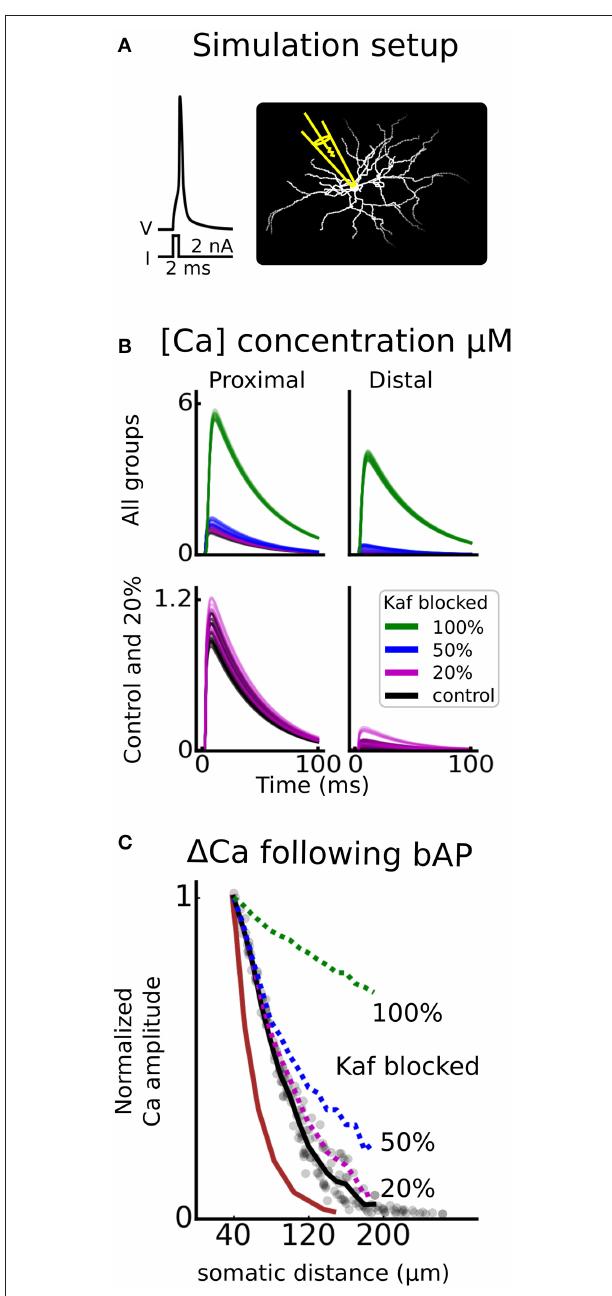
FIGURE 5 | Kaf channel control of calcium influx following a backpropagating action potential. In (A) , an illustration of the simulation setup is shown. An action potential is triggered by giving a strong depolarizing current pulse (2 nA, 2ms) to the soma, and the calcium (Ca) concentration is monitored as a function of somatic distance. Similar to florescent imaging. This setup is repeated for different proportions of Kaf channel blocking; 100, 50, 20, and 0% (control). In (B) , example traces of concentration are shown for either proximal (30–50 µ m), or distal (170–200 µ m) dendritic compartments. The upper panel shows all groups of blocking proportions and the lower panel only holds control and the assumed proportion blocked by dopamine (20%). In (C) , the mean change in amplitude of the Ca concentration, is plotted, as a function of somatic distance. The curves are normalized to the proximal location, mimicking experimental data (brown trace, Day et al., 2008).